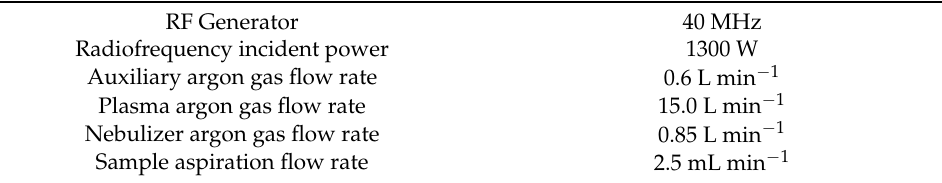
Table 1. Working parameters of the ICP-AES